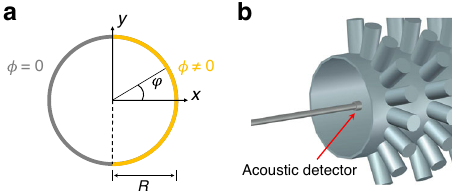
Fig. 7 The coordinate and the experimental scheme. a The polar coordination in the metasurface waveguide. The gray and yellow color denote the conventional sound hard boundary and metasurface boundary respectively. Here, we consider the re fl ection phase of the metasurface is ϕ = π (corresponding to the sound soft boundary). b the experimental scheme to detect the SAM density. The acoustic detector is inserted into the waveguide, moved by the autostage and recording the acoustic fi